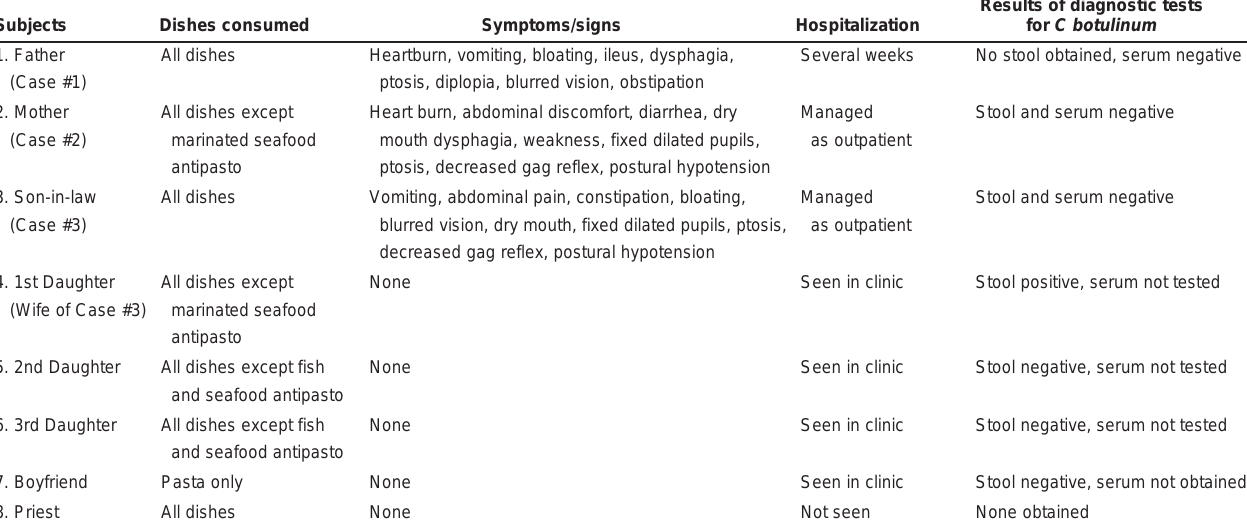
TABLE 1 Botulism outbreak and relationship to a family